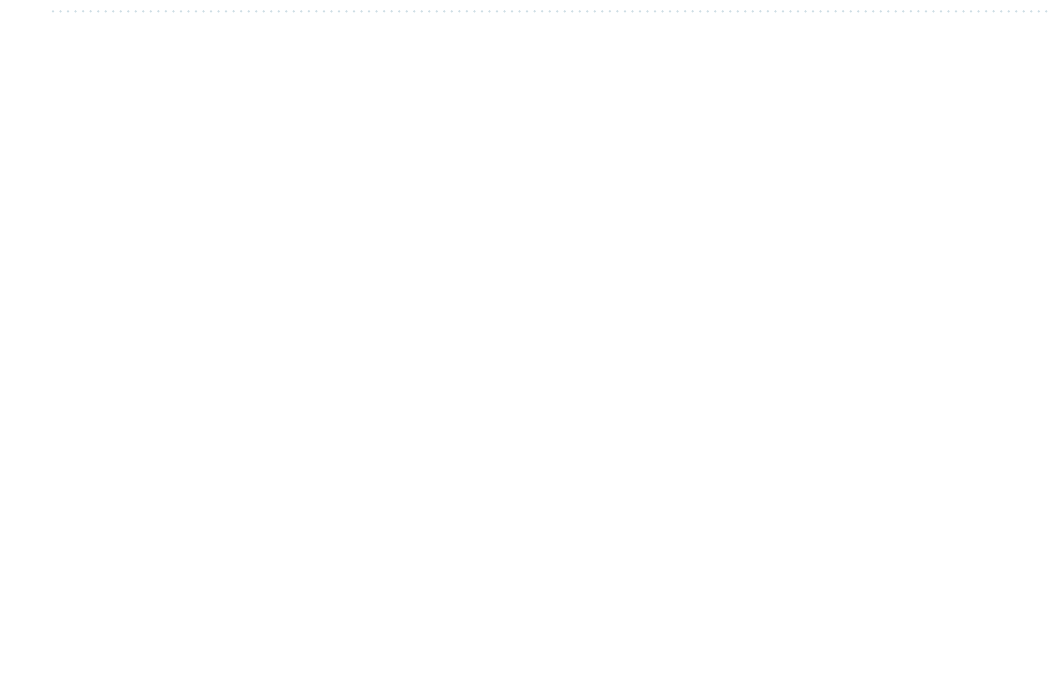
Figure 7. Astigmatism on the double angle plot 6 months post-op in PDS. The trend is ATR. The yellow dots represent a single subject’s